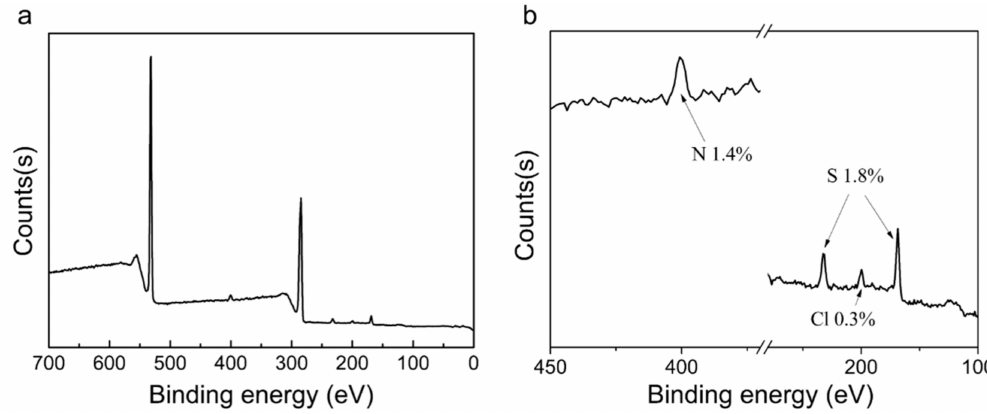
Figure 7. XPS spectra of